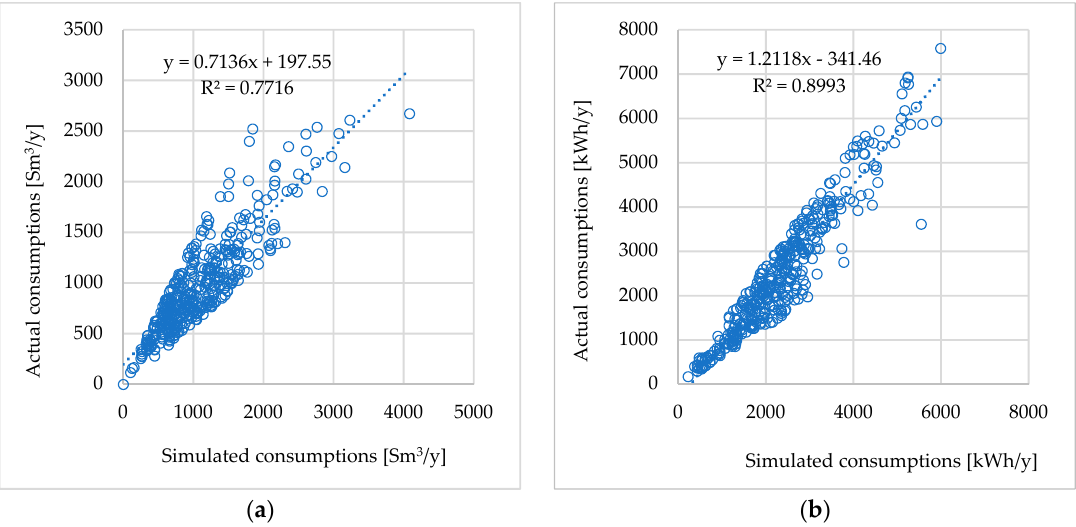
Figure 4. Actual consumptions vs. simulated consumptions ( a ) Natural Gas; ( b ) Electricity.